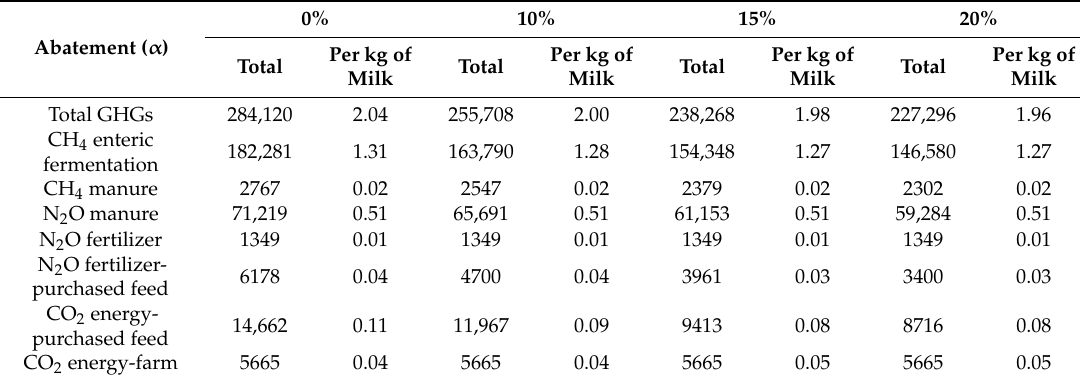
Table 7. Annual GHG emissions of the semi-intensive farm (in kg of CO 2 -eq).